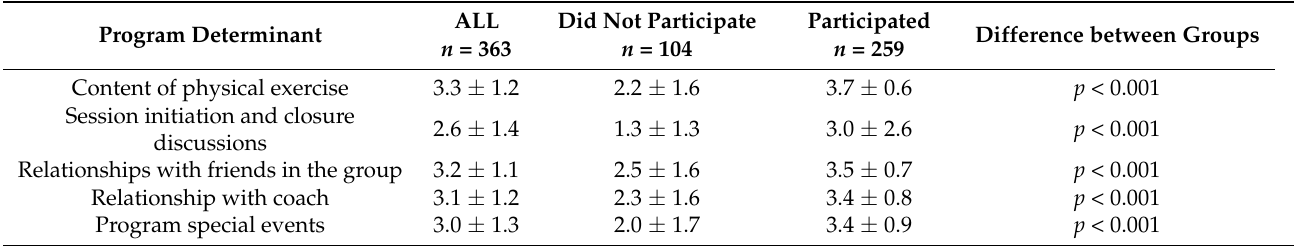
Table 3. Assessment of how meaningful the sports program determinants are to adolescents during the COVID-19 lockdown grouped by participation in organized sports programs.